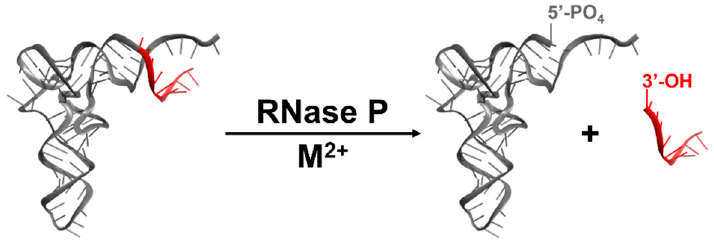
Figure 1. RNase P enzymes catalyze metal ‐ dependent, endonucleolytic cleavage of pre ‐ tRNA (adapted with permission from [7]).